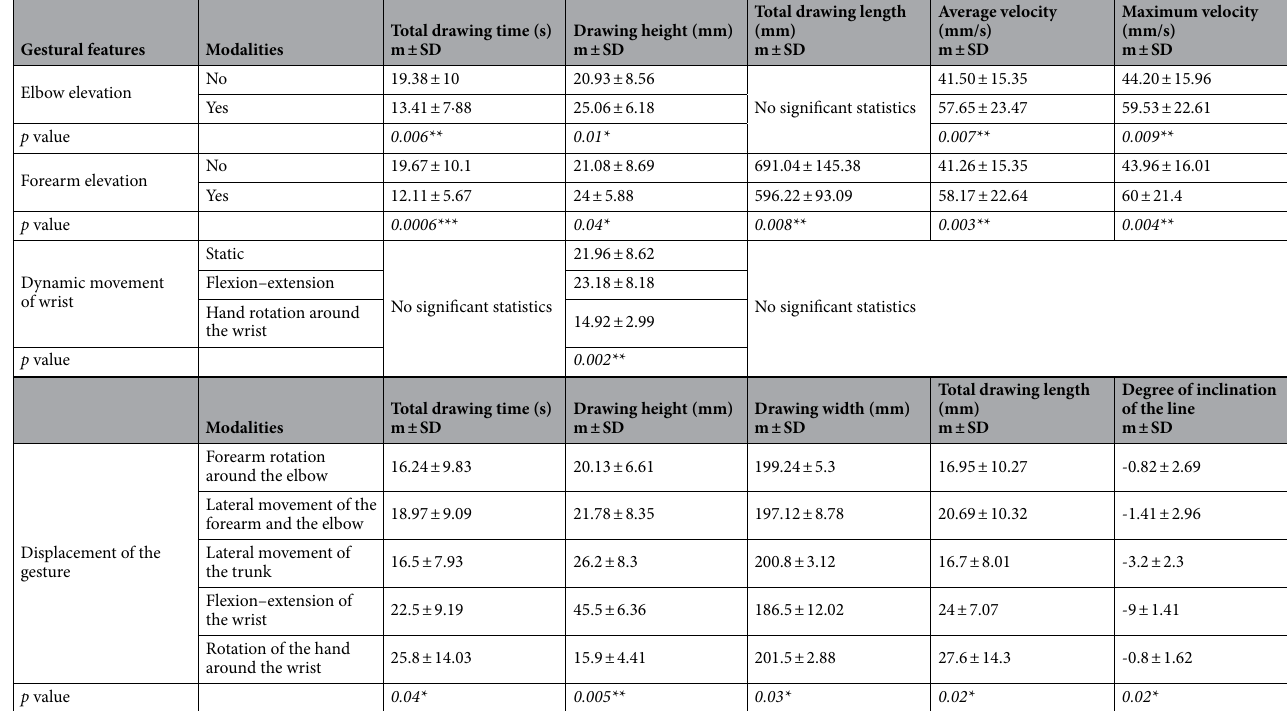
Table 4. Results of statistical significant correlations between postural and gestural features and spatial– temporal/kinematics measures in sample 2 (N = 122) for the copy of a line of cycloid loops. m mean,